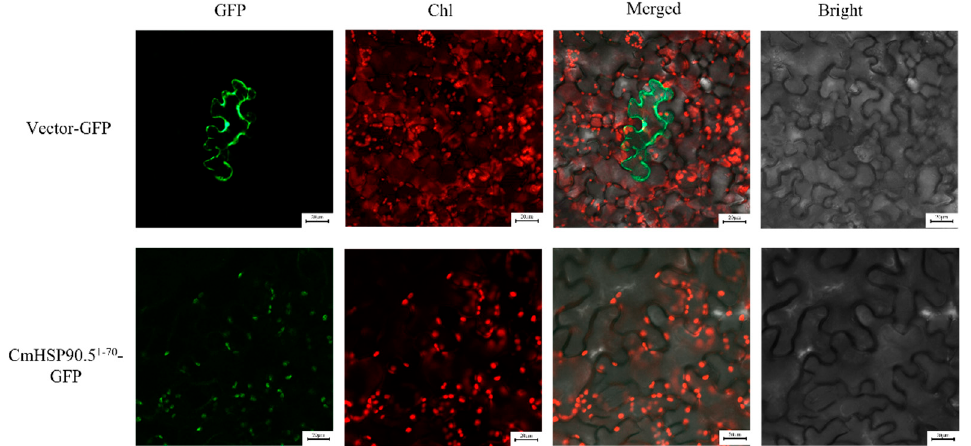
Figure 4. Subcellular localization of CmHSP90.5. 35: CmHSP90.5 1 − 70 : GFP-fused protein was transi- ently expressed in epidermal cells of Nicotiana benthamiana , and GFP-fluorescent signals and chlo- rophyll (autofluorescence) were monitored by confocal microscopy. Bars: 20 µm, GFP: green fluo- rescent protein.